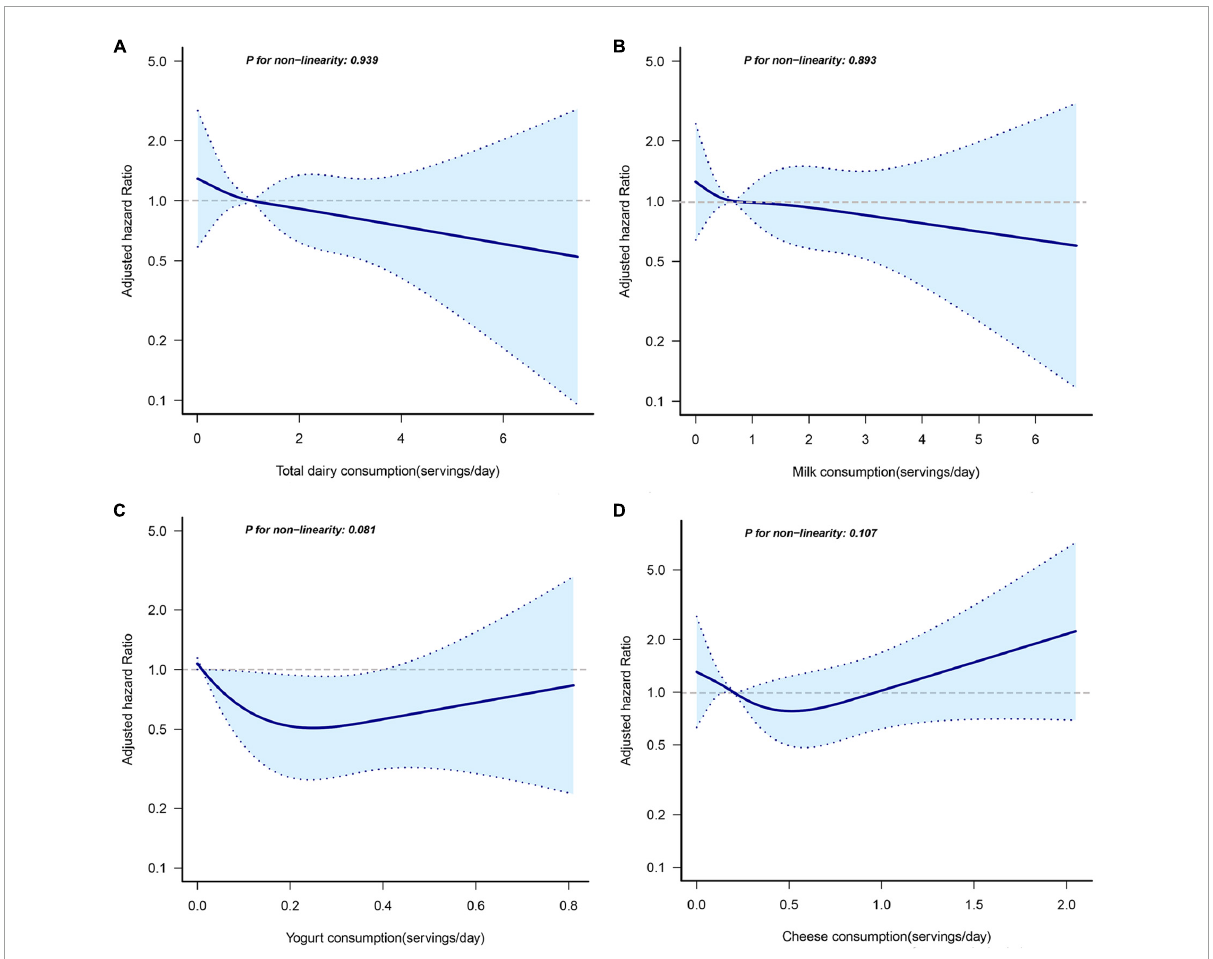
FIGURE1 Non-linear dose-response analysis on total dairy products (A) , milk (B) , yogurt (C) , and cheese (D) consumption and incidence of EC. Hazard ratios were calculated by restricted cubic spline regression with four knots (i.e., the 5th, 35th, 65th, and 95th percentiles) after adjusting for age (years), alcohol drinking status (never, current, former), smoking status (never, current, former), occupation (not working, working, retired, others), body mass index ( < 25 kg/m 2 , ≥ 25 kg/m 2 ), total calorie intake (kcal/day). The solid line represents a non-linear trend, and dashed lines represent 95% confidence